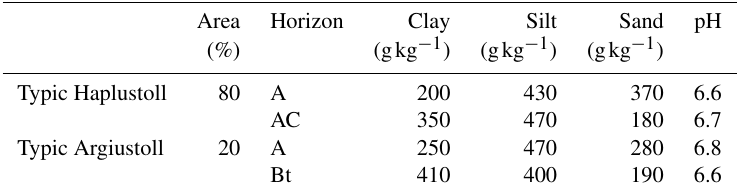
Table 1. Main characteristics of the soils of the study region.